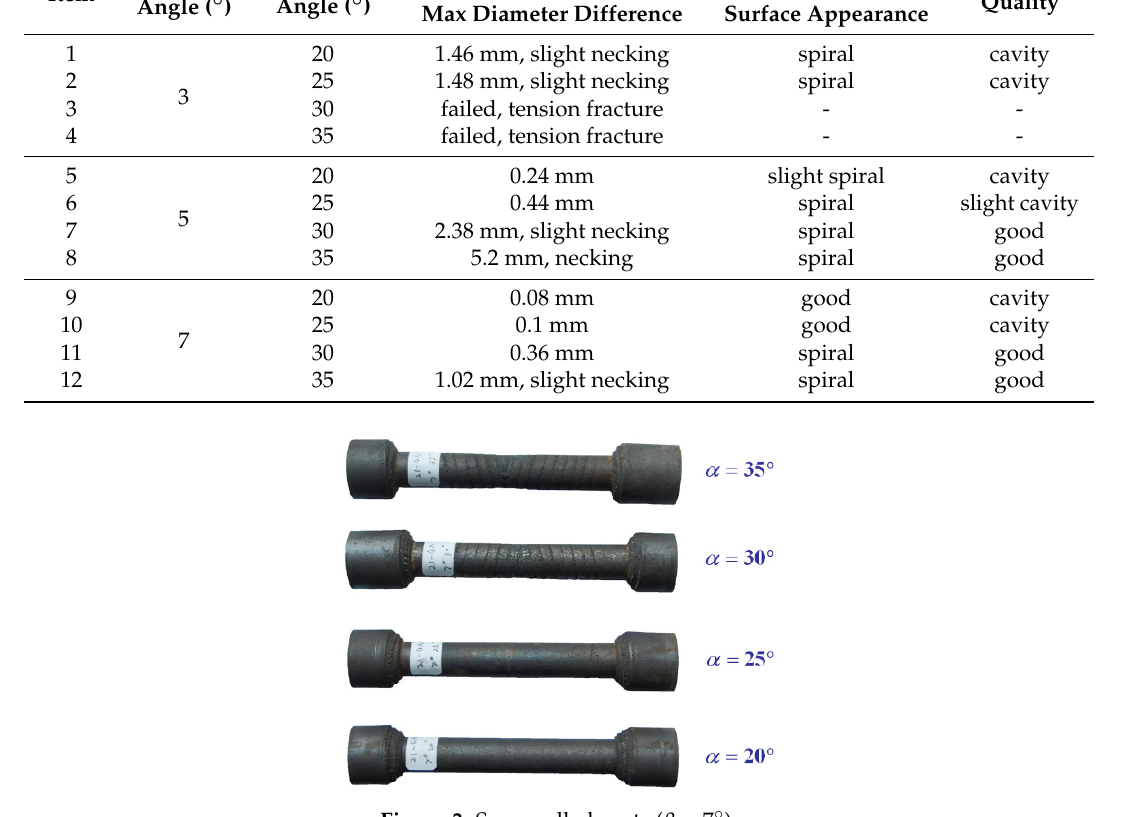
Figure 3. Some rolled parts ( β = 7°).